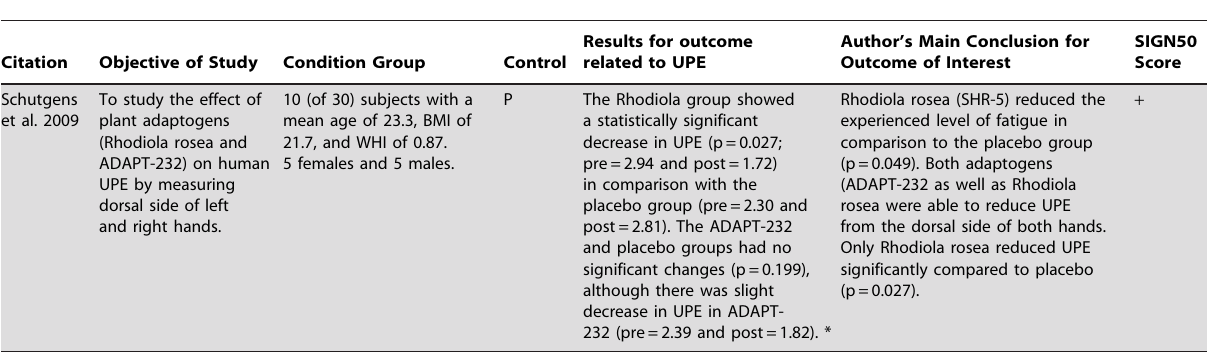
Table 2. Descriptive data for randomized controlled trials that have an